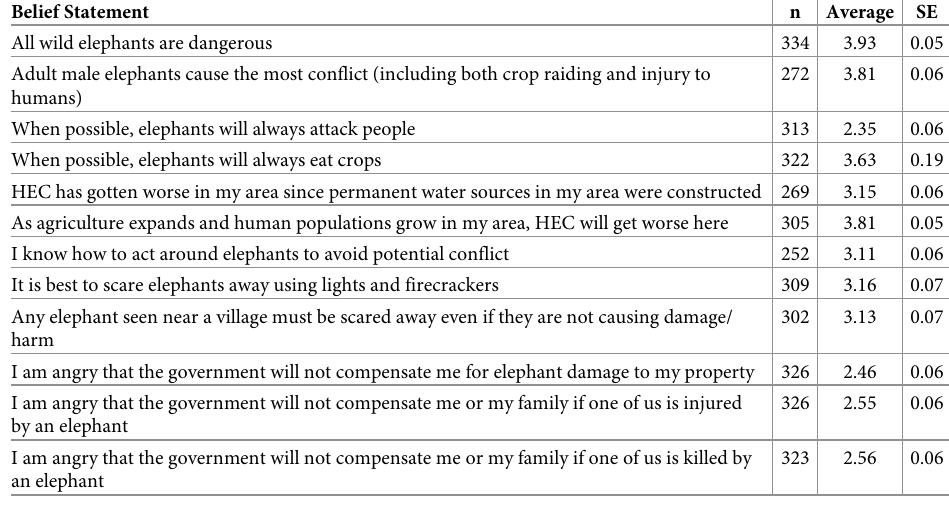
Table 2. Participant’s beliefs about human elephant conflict in the Bago-Yangon and Ayeyarwady regions of Myanmar from May 2017 to December 2018. Belief Statement n Average SE All wild elephants are dangerous 334 3.93 0.05